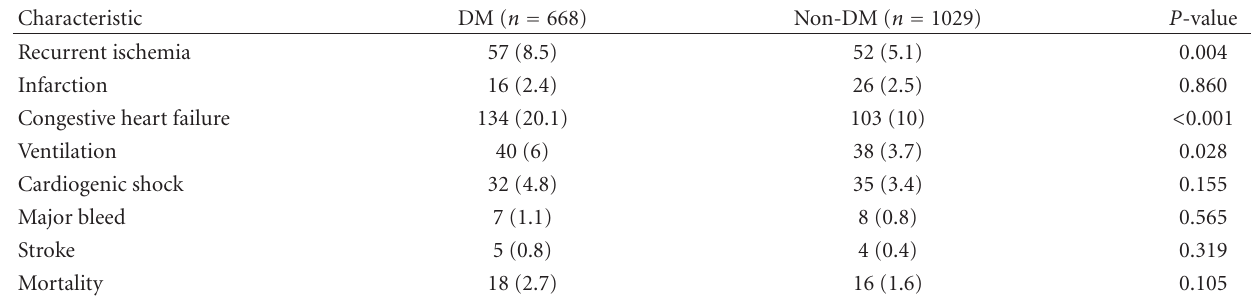
Table 3: In-hospital outcome in acute coronary syndrome diabetic and nondiabetic